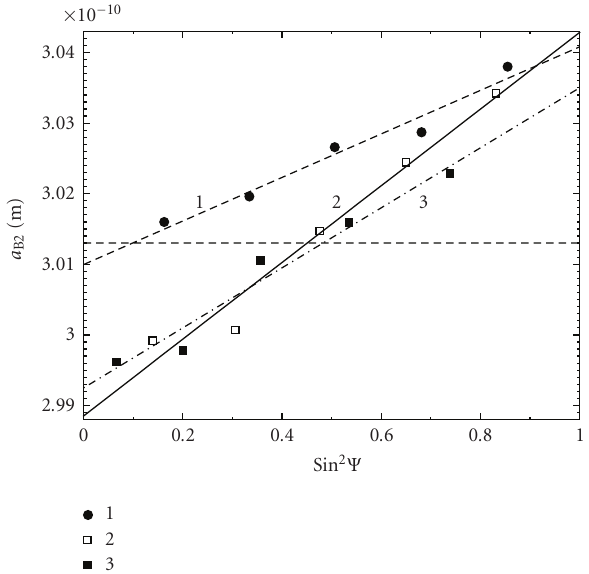
Figure 5: Lattice parameter a B 2 versus sin 2 ψ in the TiNi specimens after irradiation with 20 pulses at E 1 = 4J/cm 2 : α = 1 ◦ (1), α = 3 ◦ (2) and α = 10 ◦ (3); a 0 is the lattice parameter of the B2 phase in the initial